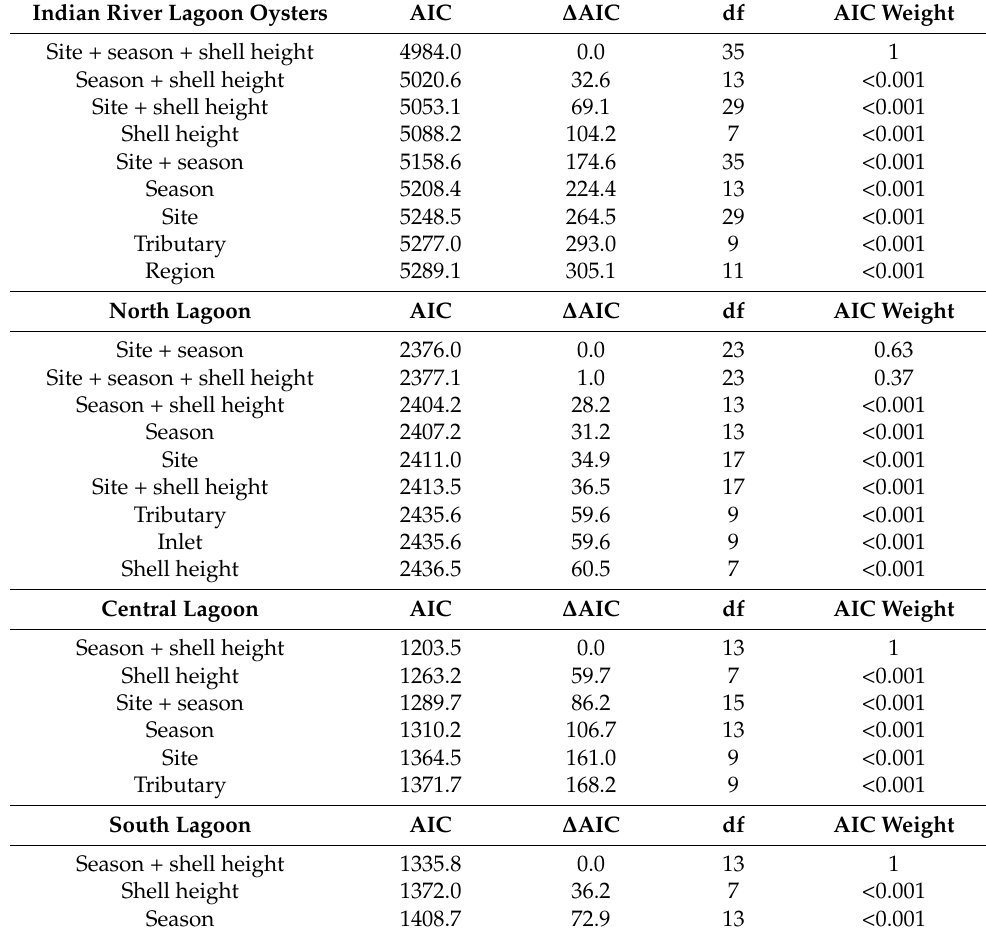
Table 3. Zero-inflated negative binomial GLM models of MP abundance in Indian River Lagoon oys- ters, overall and by region. Values reported are AIC, delta AIC, degrees of freedom, and AIC